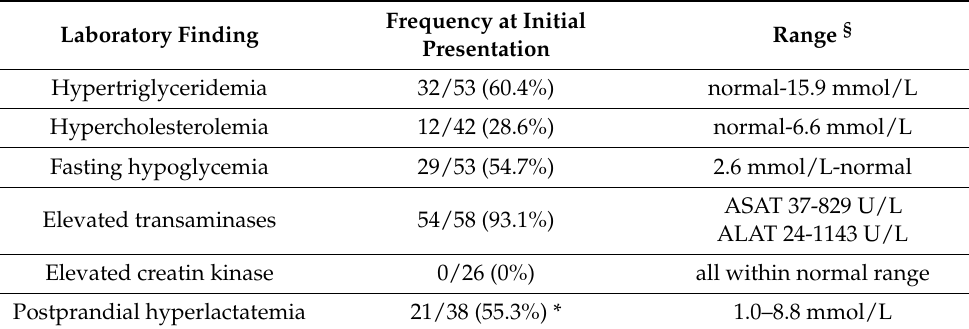
Table 2. Laboratory findings, their frequency at initial presentation and range of laboratory values reported in patients with GSD